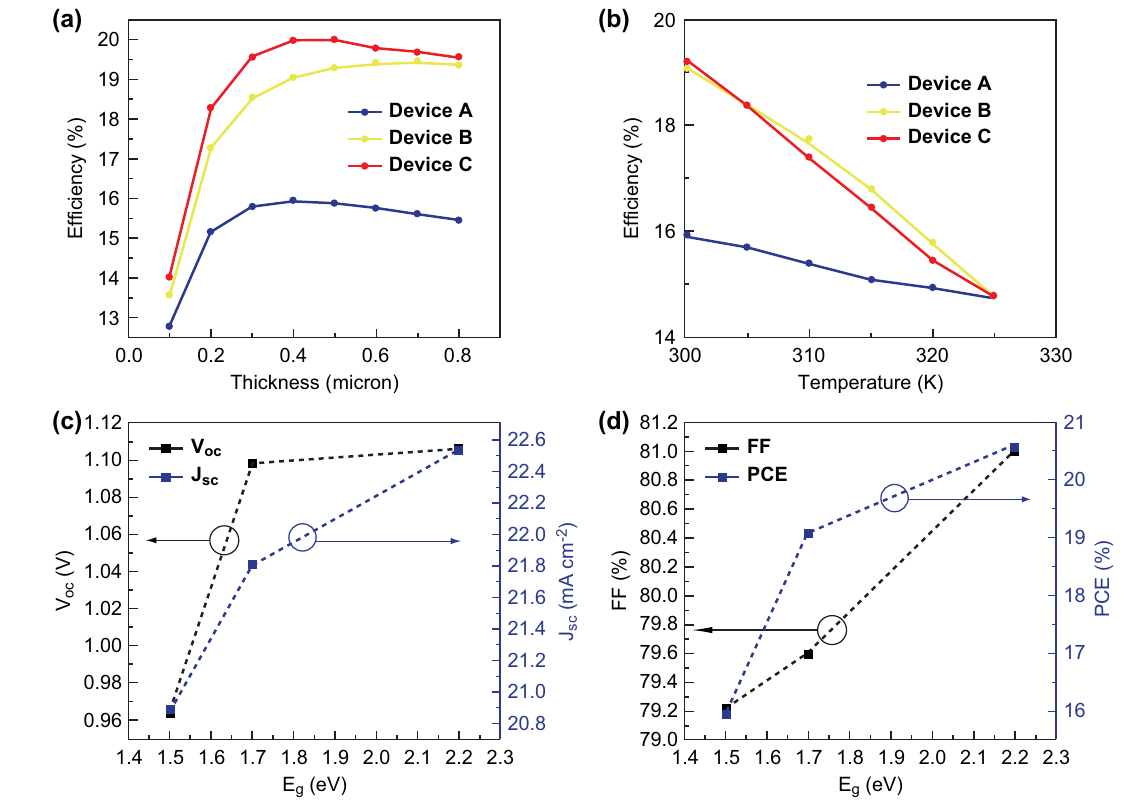
Fig. 3 a Variation (simulated) of PCE obtained as a function of thickness of photoactive materials. b Variation (simulated) of PCE as a function of operating temperature. c , d Variation (simulated) of photovoltaic parameters as a function of bandgap energy in perovskite materials Table 2 Simulated photovoltaic characteristics of solar cells measured under standard AM1.5G illumination at 100 mW cm - 2